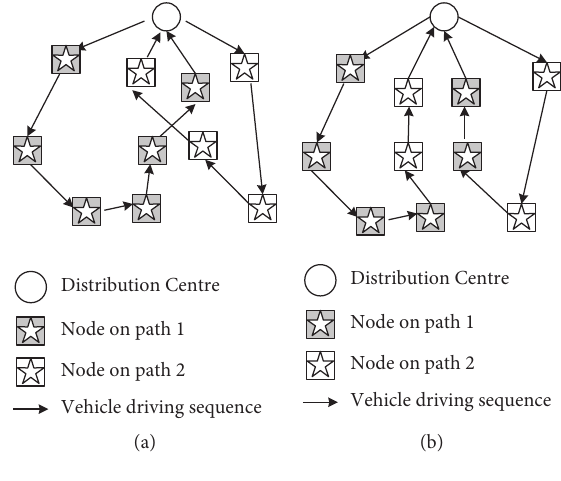
Figure 3: Cross1 neighborhood